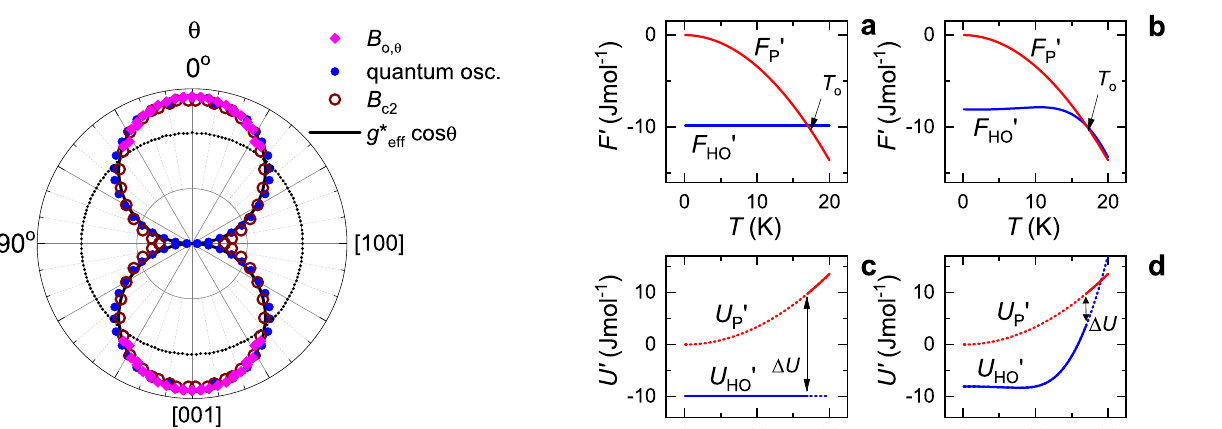
(magenta eff ; θ Fig. 7 Free and internal energies. a Free energies according to Eq. (6) in the absence of thermal excitations (i.e., Φ Δ = 0) at B = 0 for the paramagnetic (P) and hidden-order (HO) phases, computed using Δ γ = 68 mJmol − 1 K − 2 (parameter similar to that found in URu B = 0) 5 and U o ≈ 10 Jmol − 1 . At the transition T o , F 0 energies according to Eq. (6) inclusive of thermal excitations, computed using Δ γ = 68 mJmol − 1 K − 2 , Δ = 84 K, and U o ≈ 8 Jmol − 1 . c Internal energies according to Eq. (11) in the absence of thermal excitations (i.e., Φ Δ = 0) at B = 0. d Internal energies according to Eq. (11) inclusive of thermal excitations. The latent heat at the transition is given by Δ U